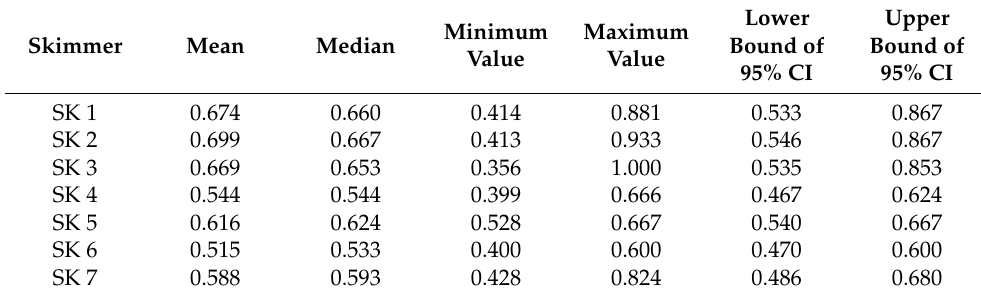
Table 3. Statistics of skimmer feasibility for offshore oil spill response in Zone 1.